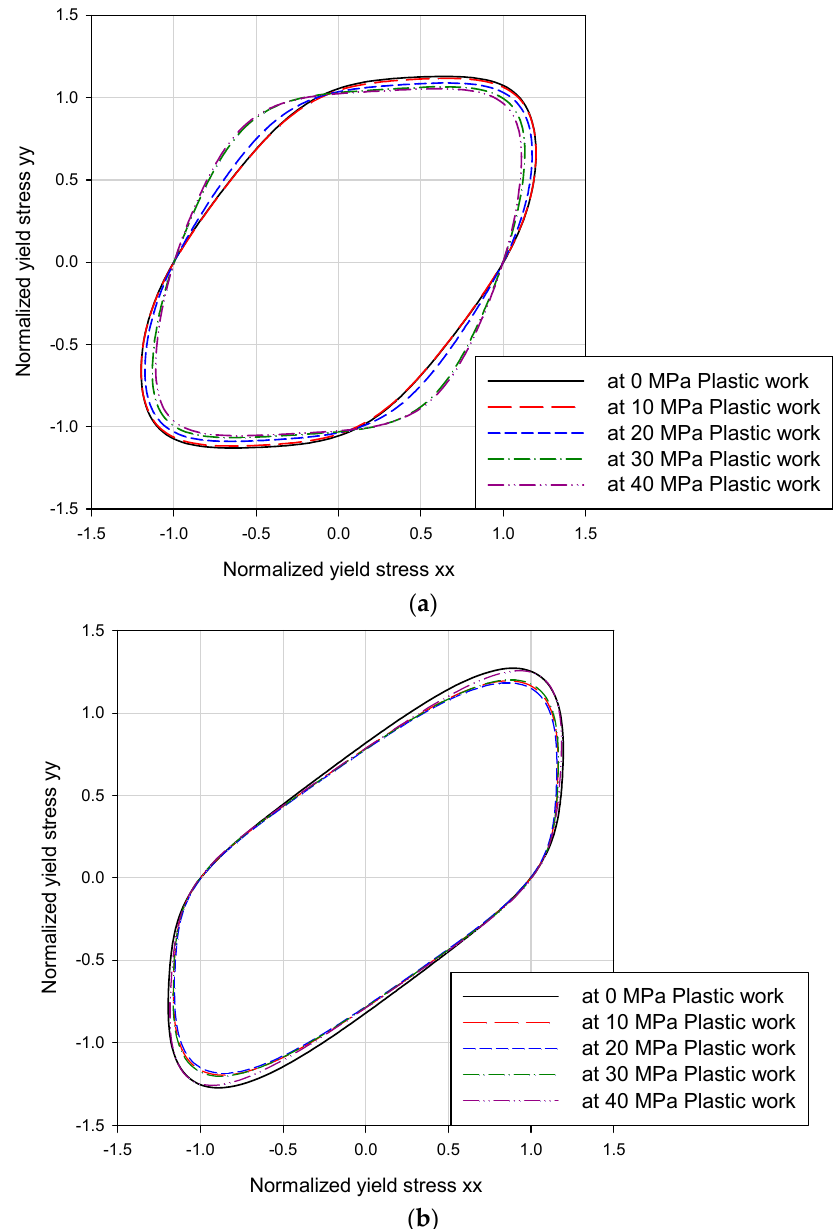
Figure 13. Comparison of the normalized contours of ( a ) the yield functions and ( b ) plastic potential function for the niobium sheet.